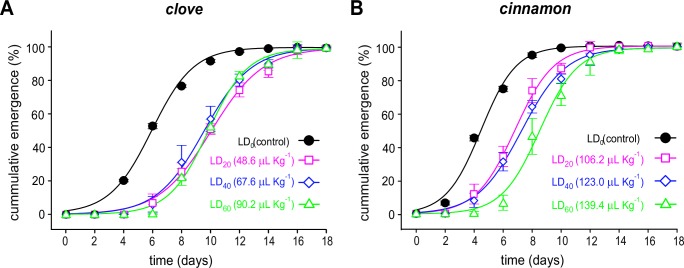
Normalized cumulative emergence of C. maculatus exposed to clove (A) and cinnamon (B) essential oils. The symbols represent the means of four replicates of the LD0 (control), LD20, LD40 and LD60 for each oil. The doses are expressed in μL of essential oil/kg beans. The vertical bars represent the SD.